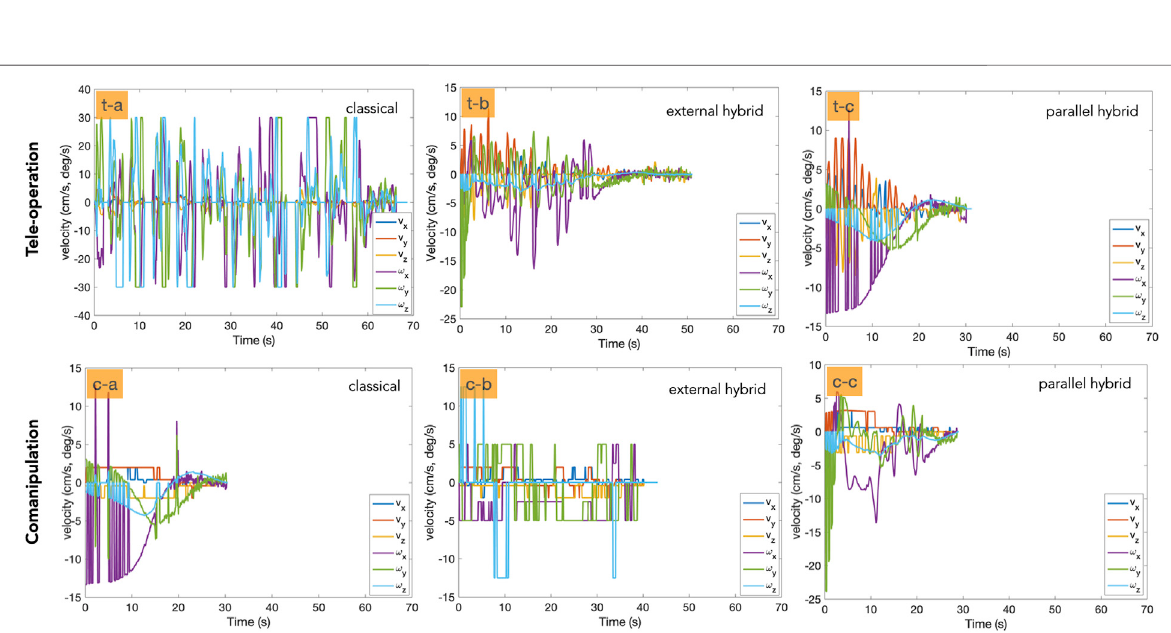
Frontiers in Robotics and AI |